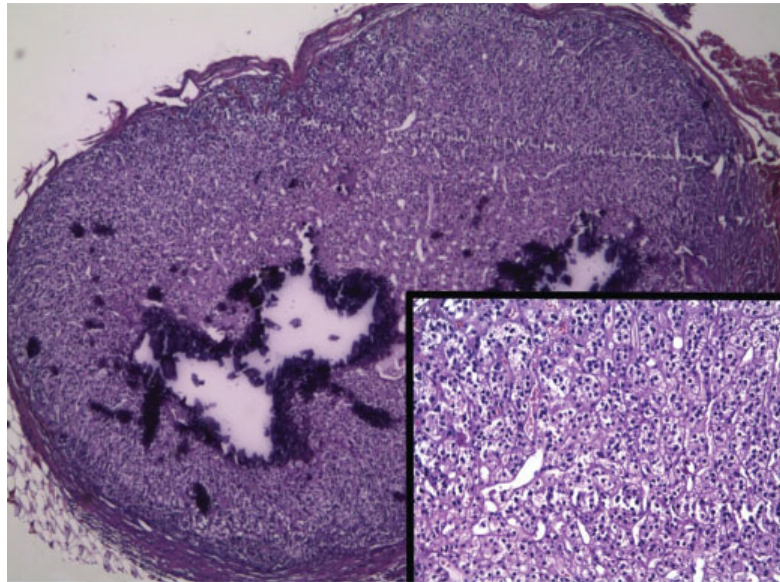
Fig. 2 Histologic section of the excised nodule, showing encapsulated adrenal cortical tissue and focal calci fi cations (hematoxylin and eosin, HE, (cid:1) 50).Inset: detail of ectopic adrenocortical tissue showing no medullary tissue or atypical cells (HE (cid:1)